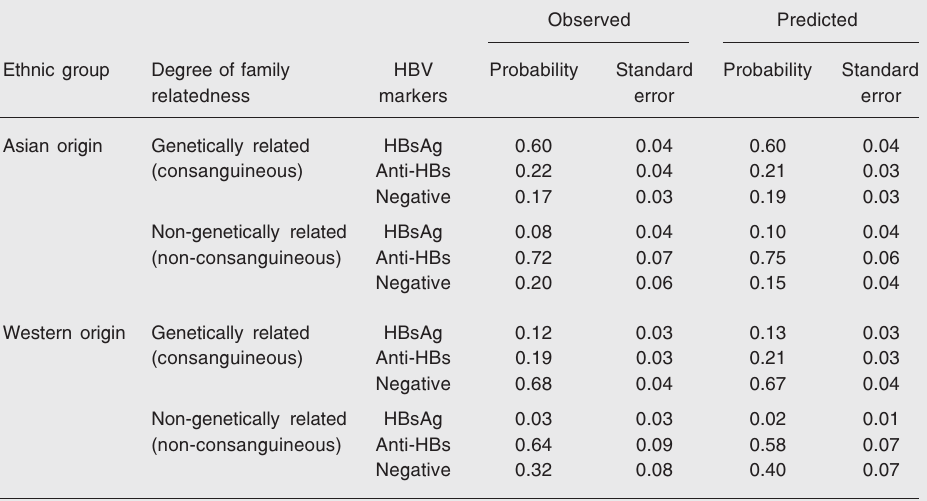
Table 6. Frequency of hepatitis B virus (HBV) markers per ethnic group and degree of familial